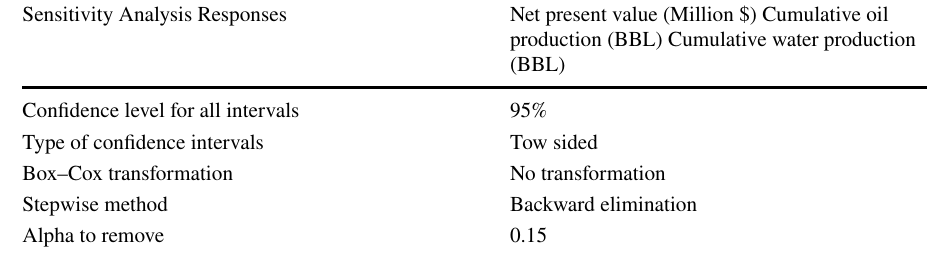
Table 5 Parameters related to sensitivity analysis by two-level Plackett–Burman